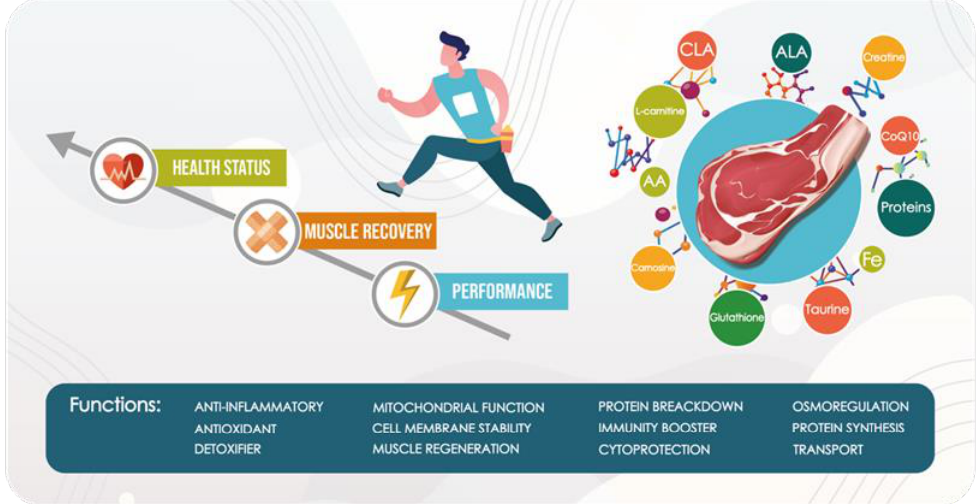
Figure 1. Schematic representation of the functional activities of meat bioactive molecules.